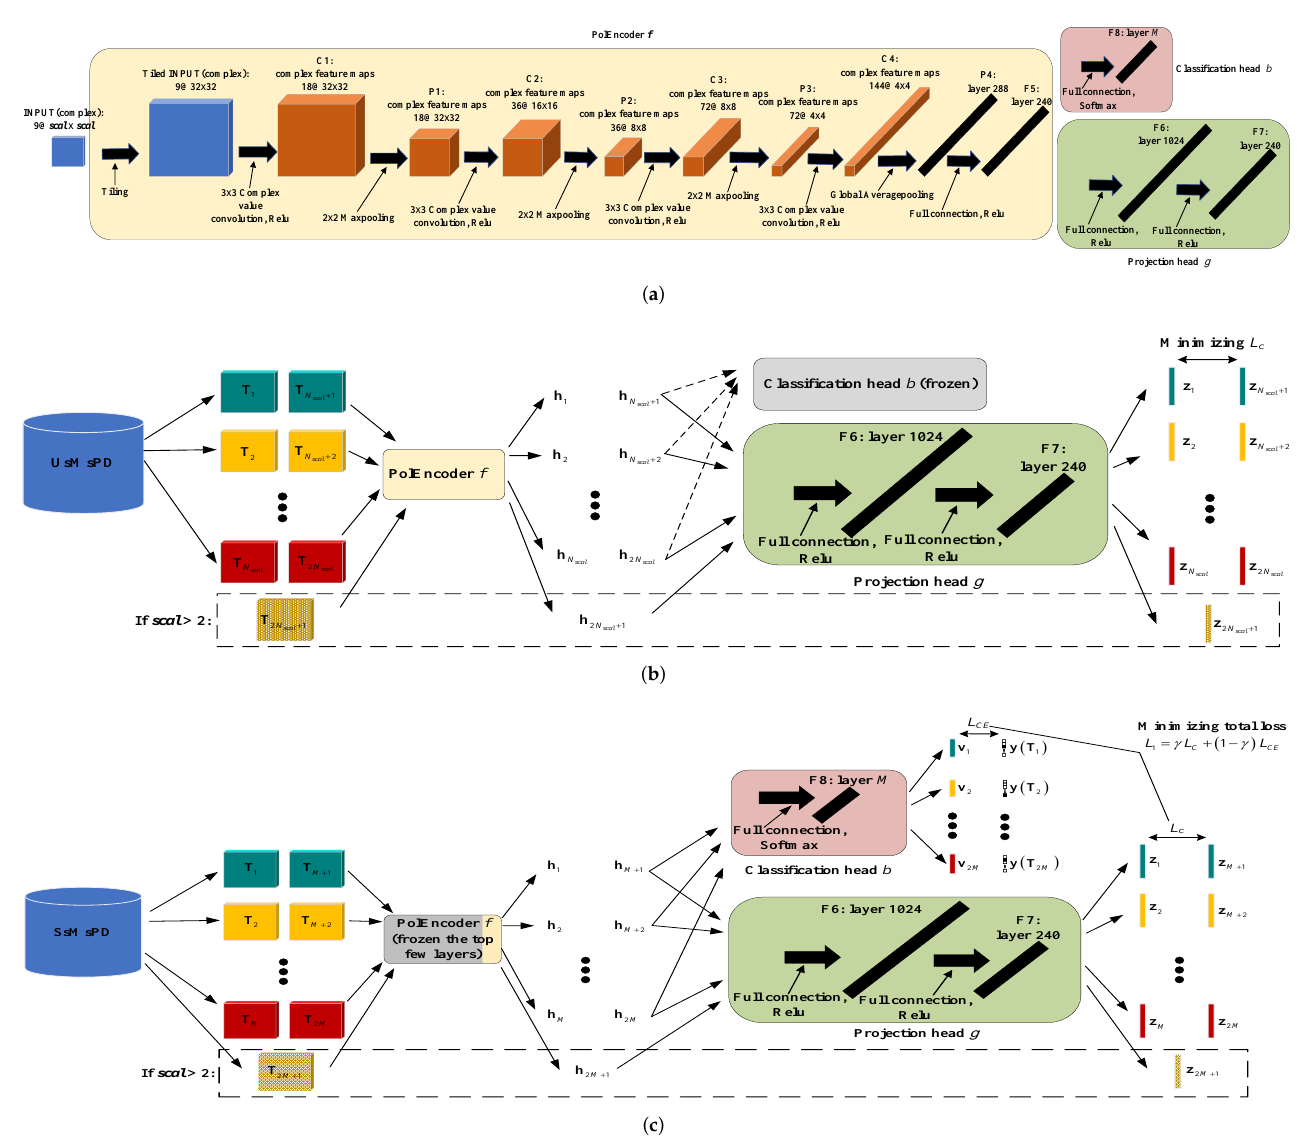
Figure 5. Illustration of the TCNet. ( a ) Structure of the TCNet. ( b ) The first contrastive learning stage of the TCNet. ( c ) The second contrastive learning stage of the